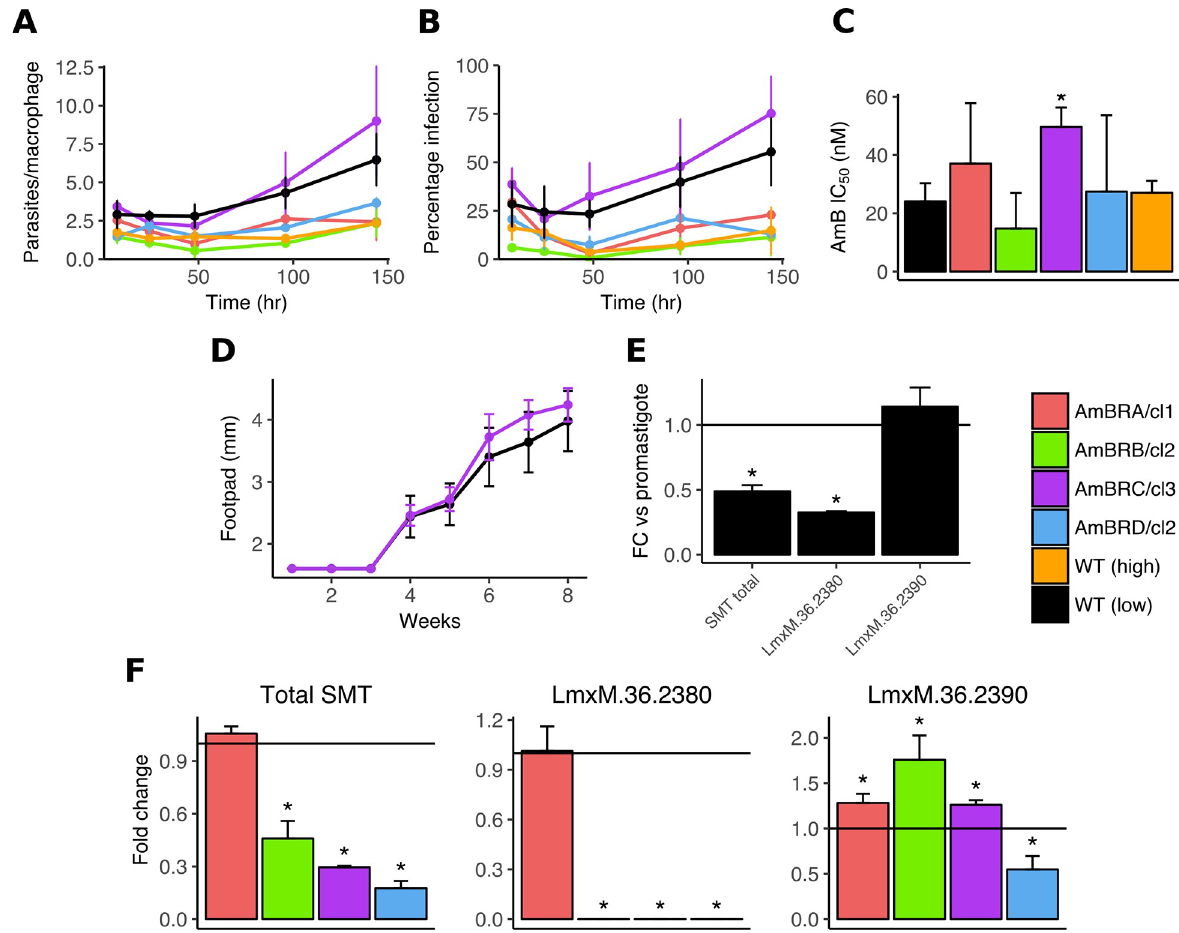
Fig 7. Infectivity of AmB-resistant parasites and SMT gene expression in intracellular amastigotes. A & B) Infectivity and replication of parasites within primary bone marrow-derived murine macrophages. Stationary phase promastigotes were used to infect macrophages for variable lengths of time and infection burdens were quantified as both parasites per infected macrophage (A) and percentage of macrophages infected (B). Error bars denote standard deviation, n = 3. C) AmB sensitivity of intracellular amastigotes. Asterisks significant differences (P < 0.05) in IC 50 from wild-type, n = 3. D) Infectivity of wild-type and AmBRC/cl3 parasites in vivo . Parasites recovered from mouse lymph nodes were brought to stationary phase and injected into mouse footpads. Footpad size was measured over time. The mean of five mice per parasite line is shown, error bars represent standard deviation. E) Fold-change in expression of SMT genes in amastigotes compared to promastigotes in wild-type parasites. Asterisks significant differences (P < 0.05) in δ Ct between the two life cycle stages (statistically significant P values are 3.00 x 10 − 4 (total SMT) and 1.42 x 10 − 5 ( LmxM . 36 . 2380 )),n = 3. F) Expression of SMT genes in intracellular amastigotes. RNA was derived from primary macrophages 72 hours after infection with stationary phase promastigotes. Asterisks denote statistically significant differences (P < 0.05) in δ Ct from